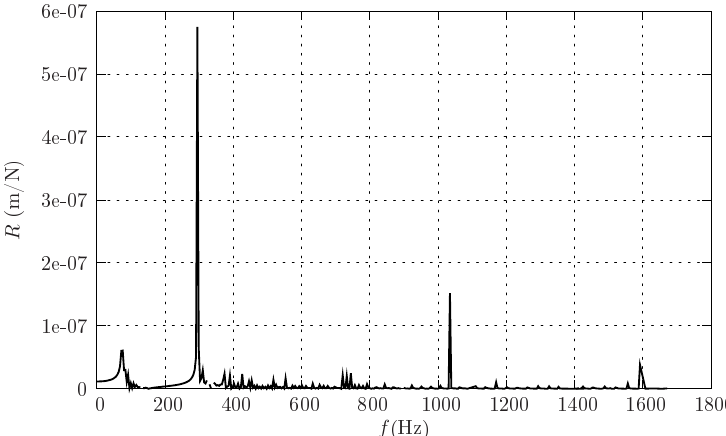
Figure 5. Receptance of the ballasted